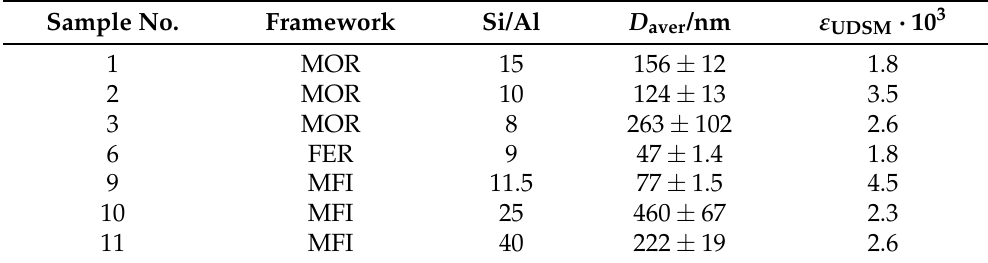
Table 3. Average nanograin size D aver of the studied zeolite samples calculated from the Debye –Scherrer formula and the strain ε UDSM calculated from the Williamson–Hall